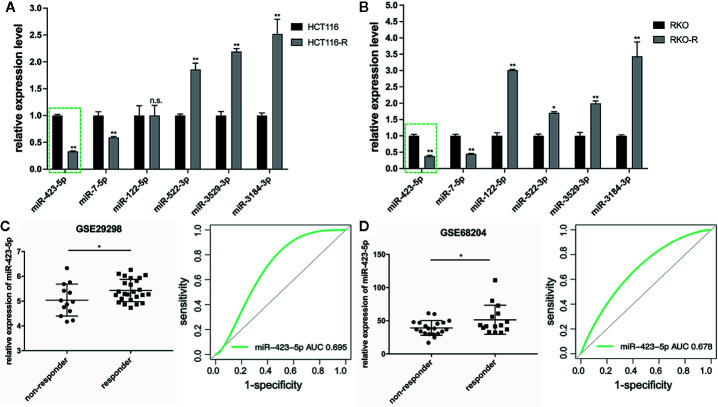
Downregulation of miR-423-5p in the radioresistant colorectal cancer cells and rectal cancer tissues from radiotherapy-resistant patients. (A, B) Quantitative RT-PCR was carried out to validate the expression level of the six DEMIs in the four colorectal cancer cell lines. (C, D) The expression of miR-423-5p was lower in non-responders (TRG 3-5) than responders (TRG 1-2) with rectal cancer (GSE29298 and GSE68204) (left panel). The receiver operating characteristic (ROC) analysis showed the sensitivity and specificity of miR-423-5p expression to discriminate responders with non-responders (right panel). The results were shown as the mean ± SD. The independent experiments were performed for at least three times. *P < 0.05, **P < 0.01, n.s. means no significance.